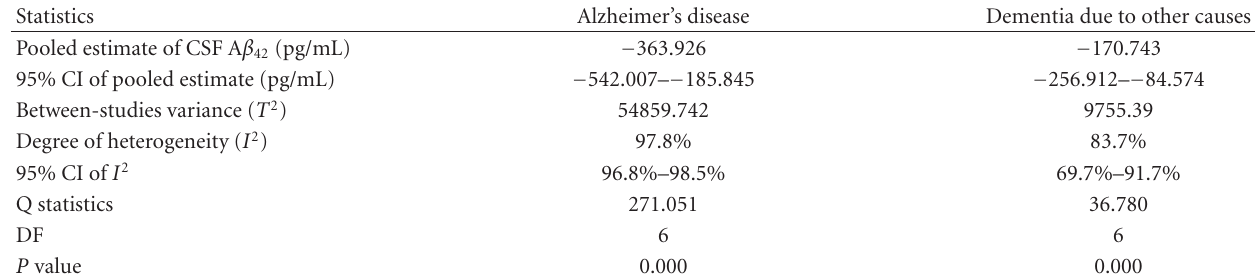
Table 6: Pooled estimate of e ff ect size with 95% CI, test of significance, and magnitude of heterogeneity of CSF A β 42 studies in Alzheimer’s disease and dementia due to other